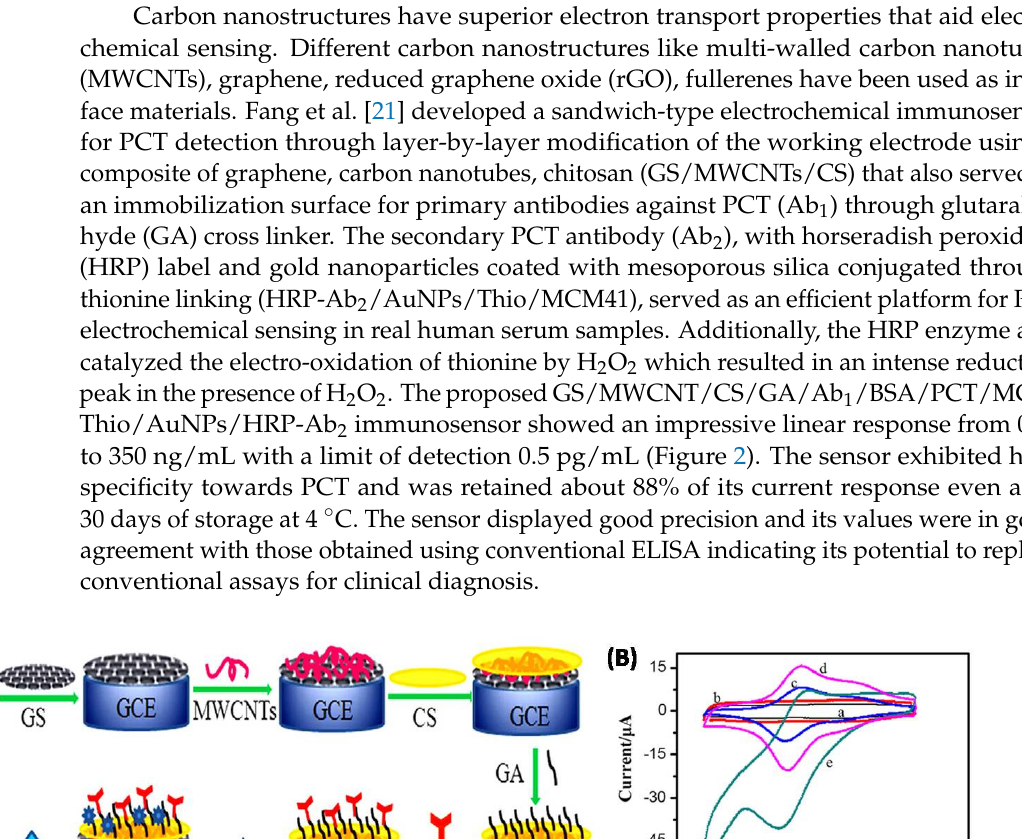
thionine (SWCNHs/HPtC/HRP/Thio/PCT-Ab 2 ) to obtain an amplified current response [23]. The proposed immunosensor SWCNH/HPtC/HRP/thi–Ab 2 /PTC/Ab 1 /rGO–Au showed good responses with linearity from 1 pg/mL to 20 ng/mL of PCT with a detection limit of 0.43 pg/mL. The HPtCs served as a biocompatible matrix for immobilization of HRP and anti- bodies as well as catalyzed the reduction of H 2 O 2 in a display of a synergistic effect with the enzyme. In a related work, the SWCNHs/HPtCs complex was chemically conjugated with the hyperbranched polymer PAMAM (G4.0) and the primary antibody (PCT-Ab 1 ).